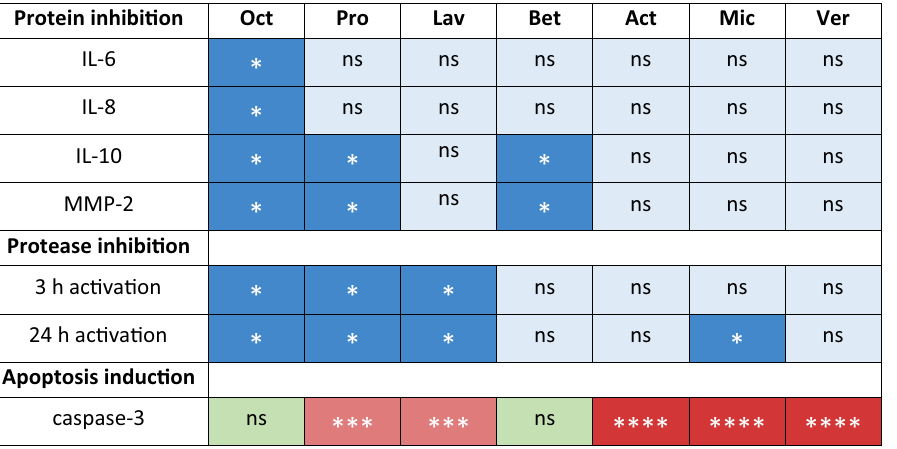
Table 3. Overview—effects of all tested wound gels compared to untreated control. A Wilcoxon matched-pairs signed rank test and a two-way analysis of variance (ANOVA) were performed for protein/protease inhibition data and for caspase-3 positive cell counts, respectively with GraphPad Prism 9.3.1. *p ≤ 0.05, ***p ≤ 0.001, ****p ≤ 0.0001, ns = not significant.